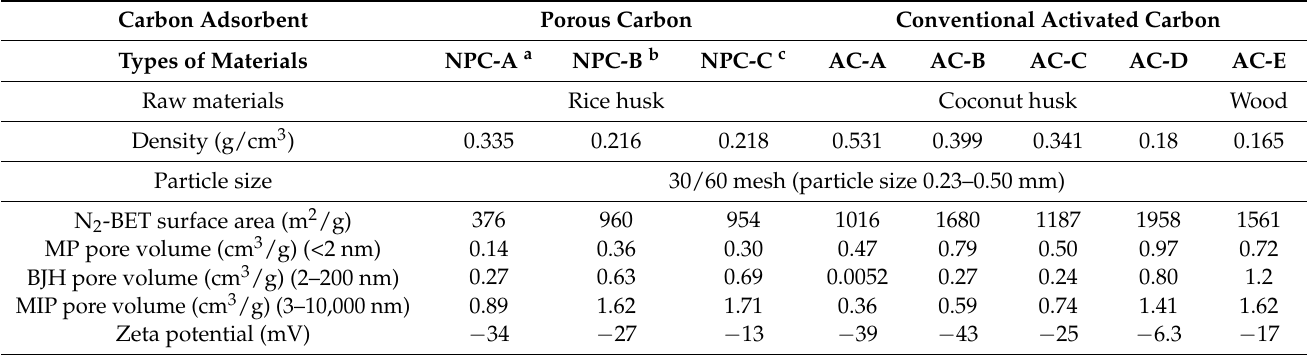
Table 1. Characteristics of three NPCs and five commercially available types of ACs.